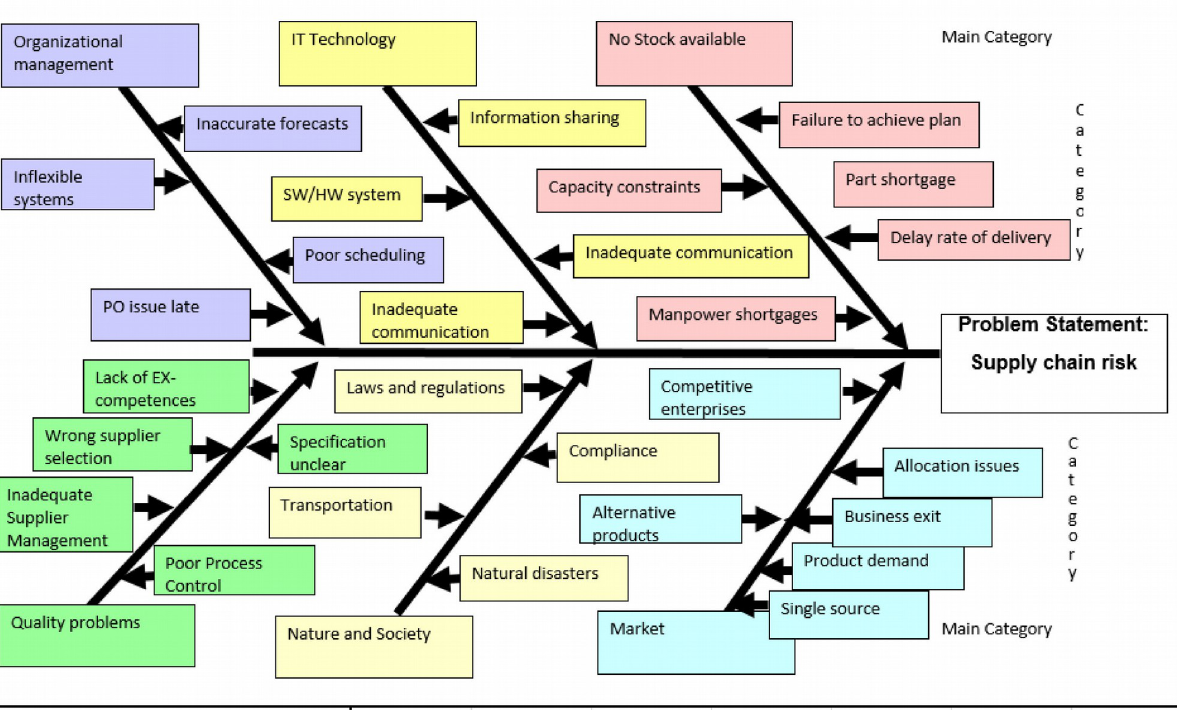
Figure 4. Ishikawa diagram. Case